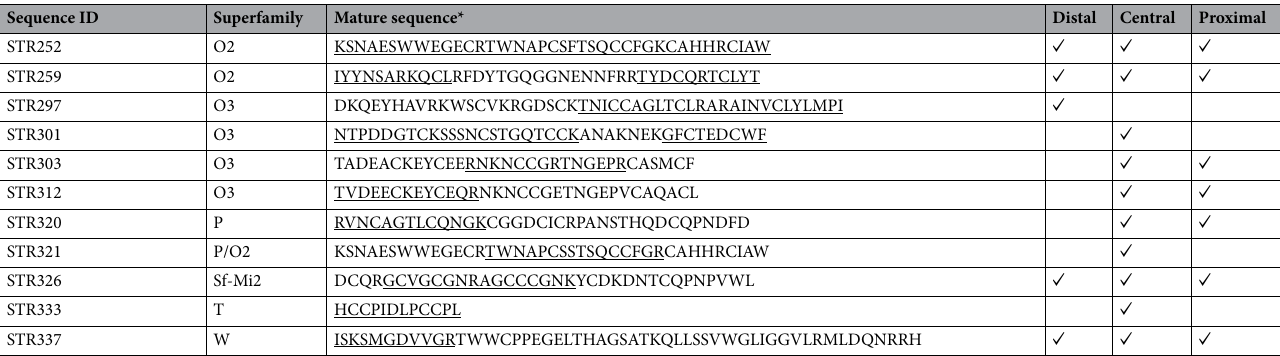
Table 1. Integration of the transcriptome and proteomic data using ProteinPilot tool. Underlined sequences are matched to 99% confidence (list of peptide fragments are shown in supplementary table S8) to the proteomic data obtained from the three venom duct sections of C. striatus. MS/MS fragments obtained from reduced-alkylated and reduced-alkylated-trypsin digested extracted venom from three venom duct sections of specimens A, B and C of C. striatus were used to map their presence in the proteome.